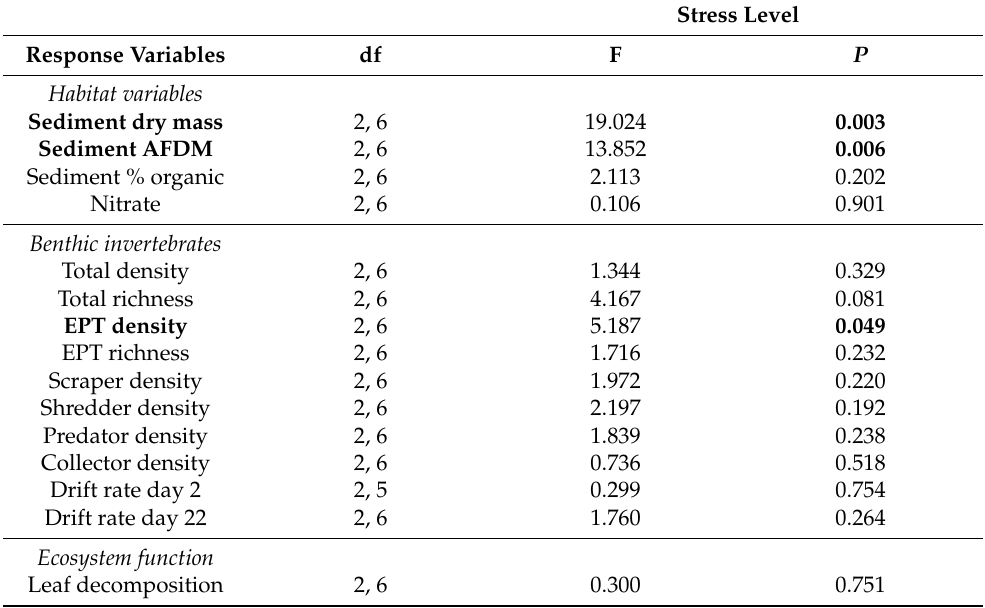
Table 4. ANOVA summary of linear models evaluating the impact of disturbance level within the tributaries on response variables of second-order channels. Significant effects ( P < 0.05) are indicated in